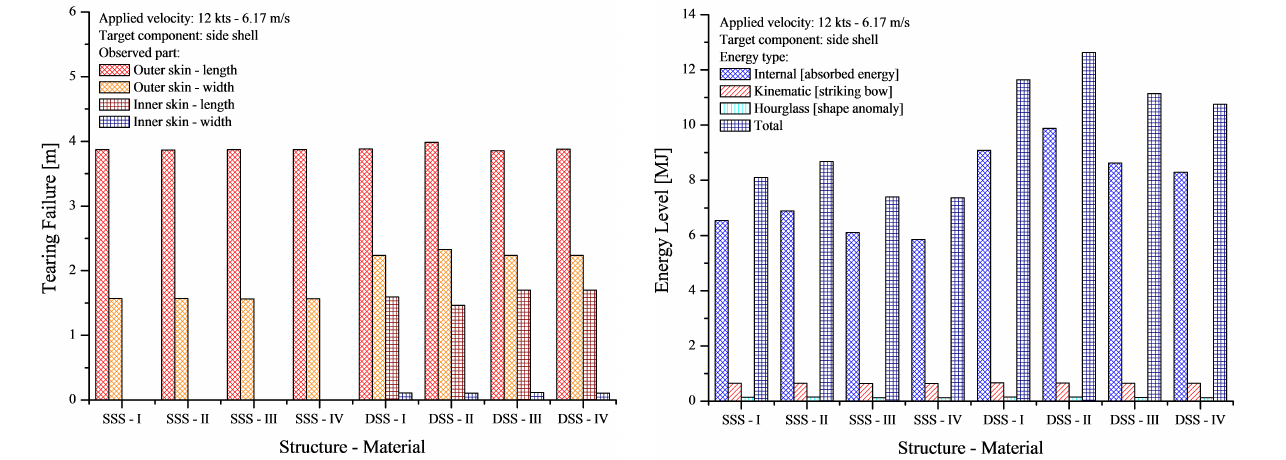
Figure 7: Failure on the struck ship accounting for determined struc- tures and materials.